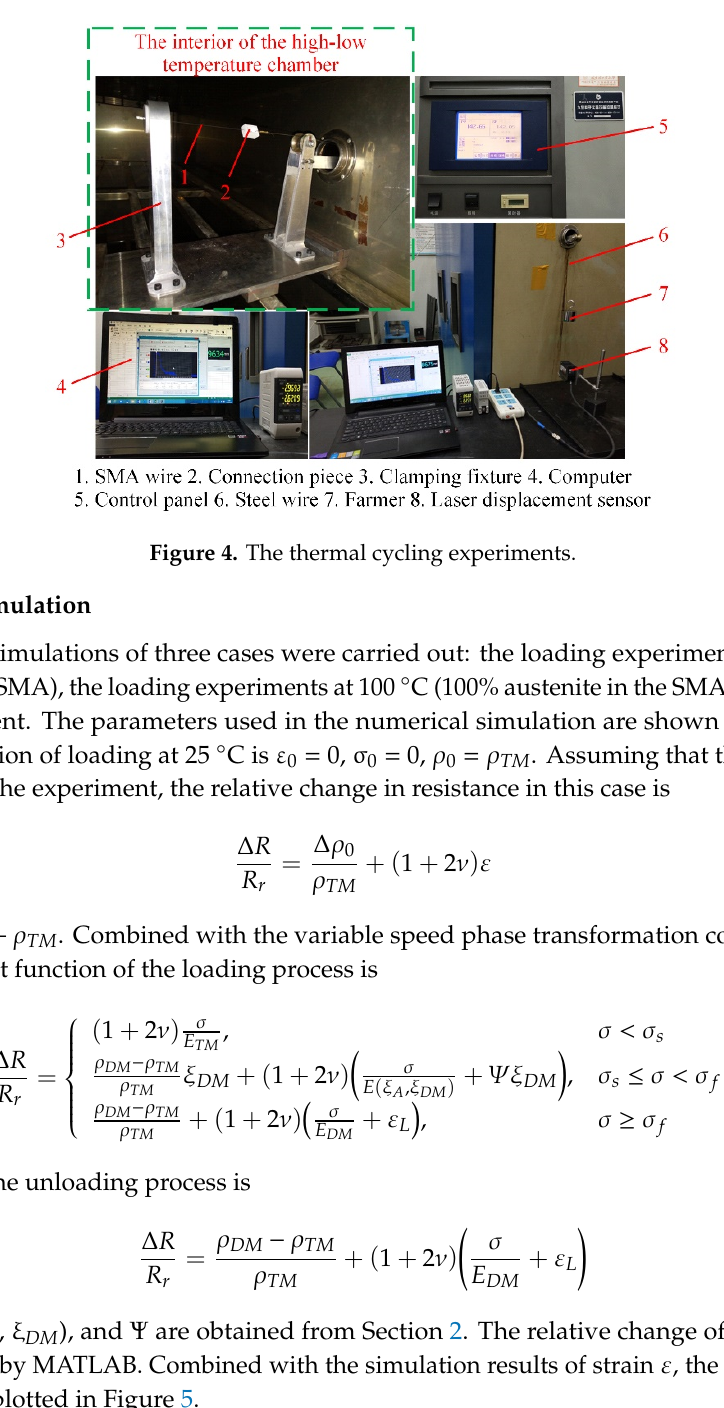
Figure 3. The loading experiments at 25 °C and 100 °C.